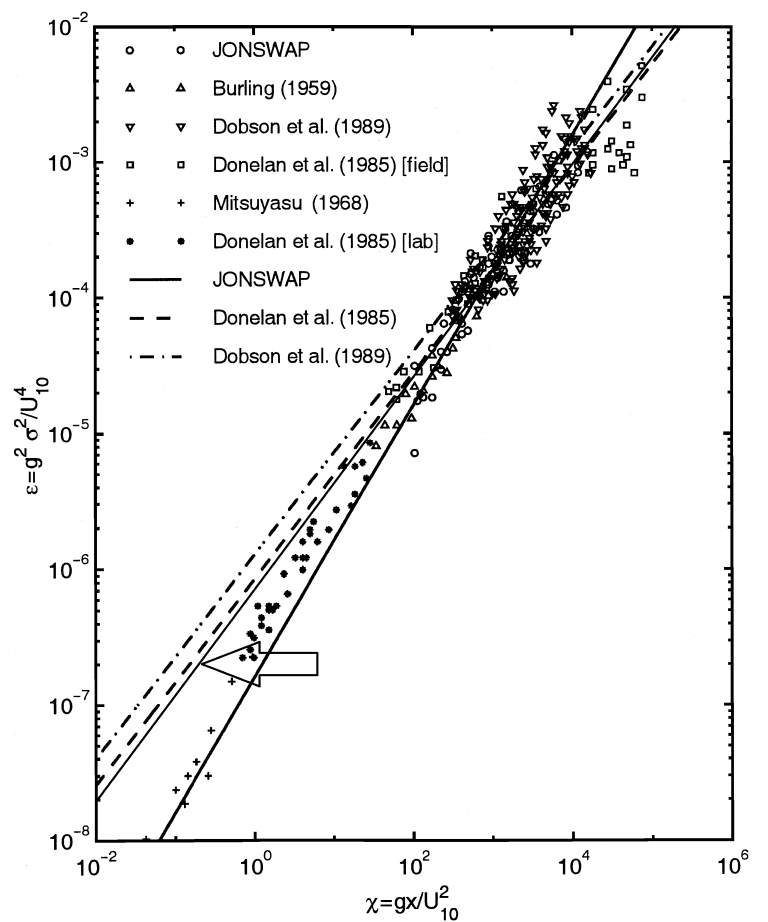
Figure 23. The solid line (pointed to by arrows) presents non-dimensional total energy from the limited fetch numerical experiments, superimposed onto Fig. 5.4, which is adapted from Young (1999). The original caption is “A composite of data from variety of studies showing the development of the non-dimensional energy, ε as a function of non-dimensional fetch, χ . The original JONSWAP study (Hasselmann et al., 1973) used the data marked, JONSWAP, together with that of Burling (1959) and Mitsuyasu (1968). Also shown are a number of growth curves obtained from the various data sets. These include JONSWAP Eq. (5.27), Donelan et al. (1985) Eq. (5.33) and Dobson et al. (1989) Eq.